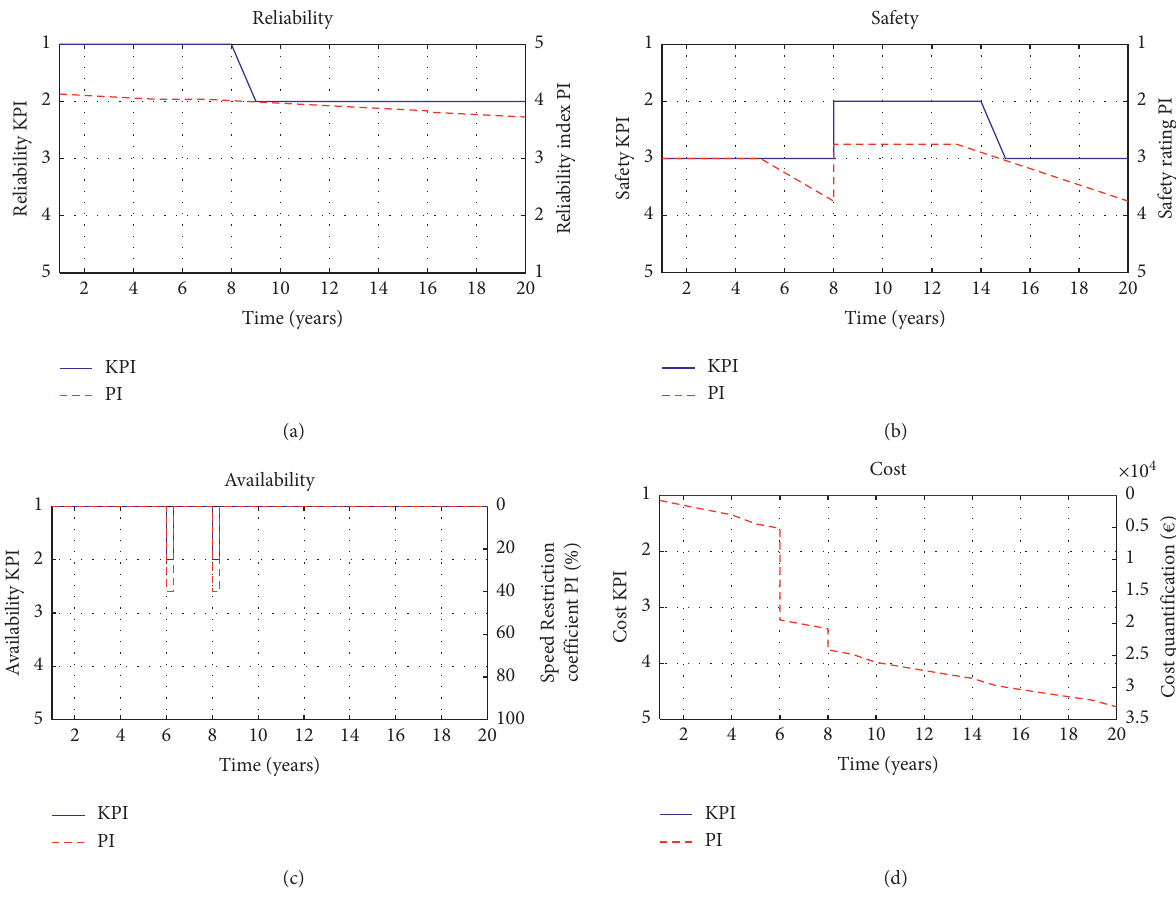
Figure 9: Bridge performance considering preventive scenario: (a) reliability; (b) safety; (c) availability; (d) cost. Table 12: Variable quantification for flow quantification.